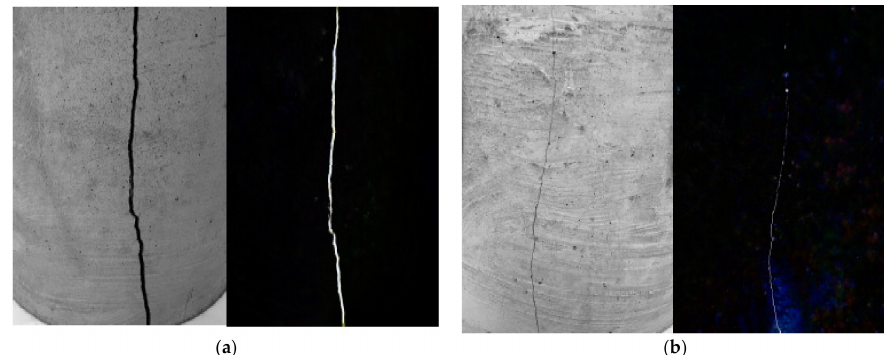
Figure 12. Shrinkage Crack Width ( a ) Without Fibers and ( b ) With Fibers